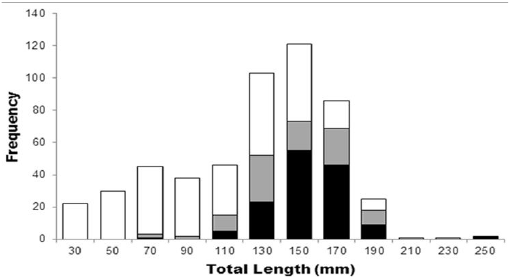
Figure 2. Total length frequency distribution for female (black), male (gray) and unidentified (white) specimens of P. managuensis at the Saco I dam, Pernambuco-Brazil